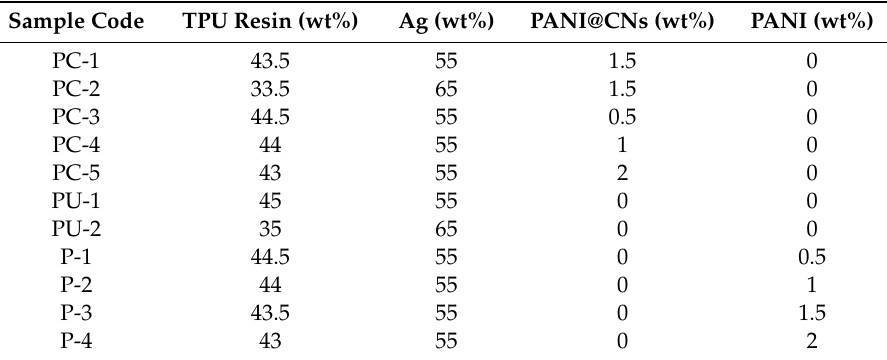
Table 1. The compositions for the prepared ECAs.